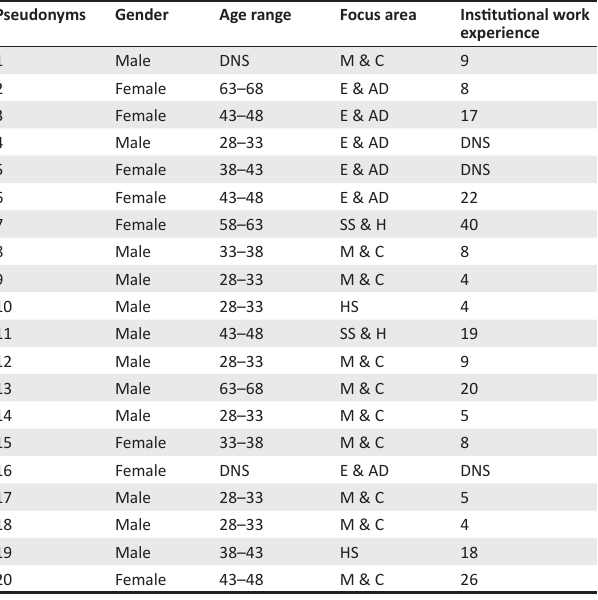
TABLE 1: Characteristics of the